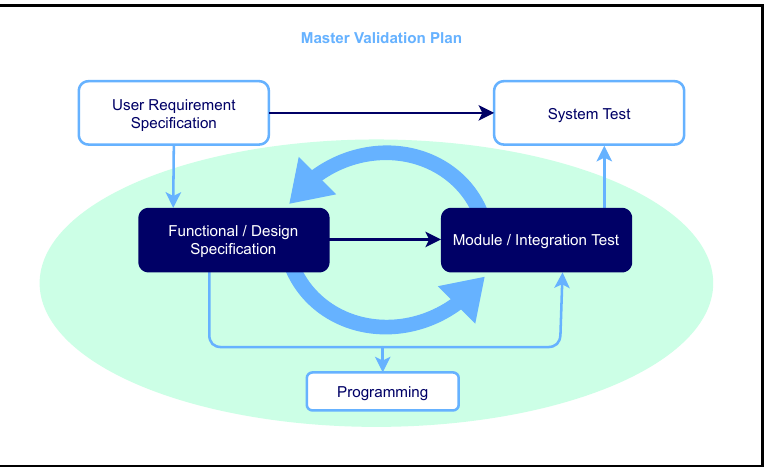
Figure 1. Waterfall (V-model) software development process model.